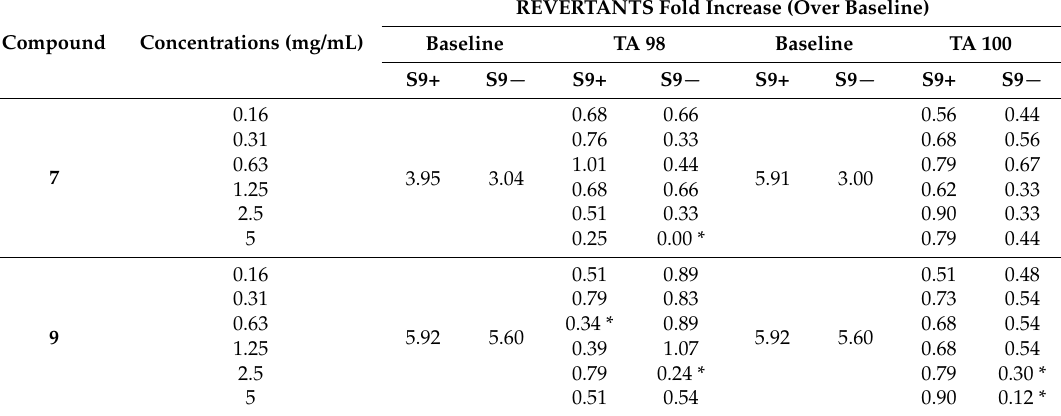
Table 5. Ames assay results of compounds 7 and 9